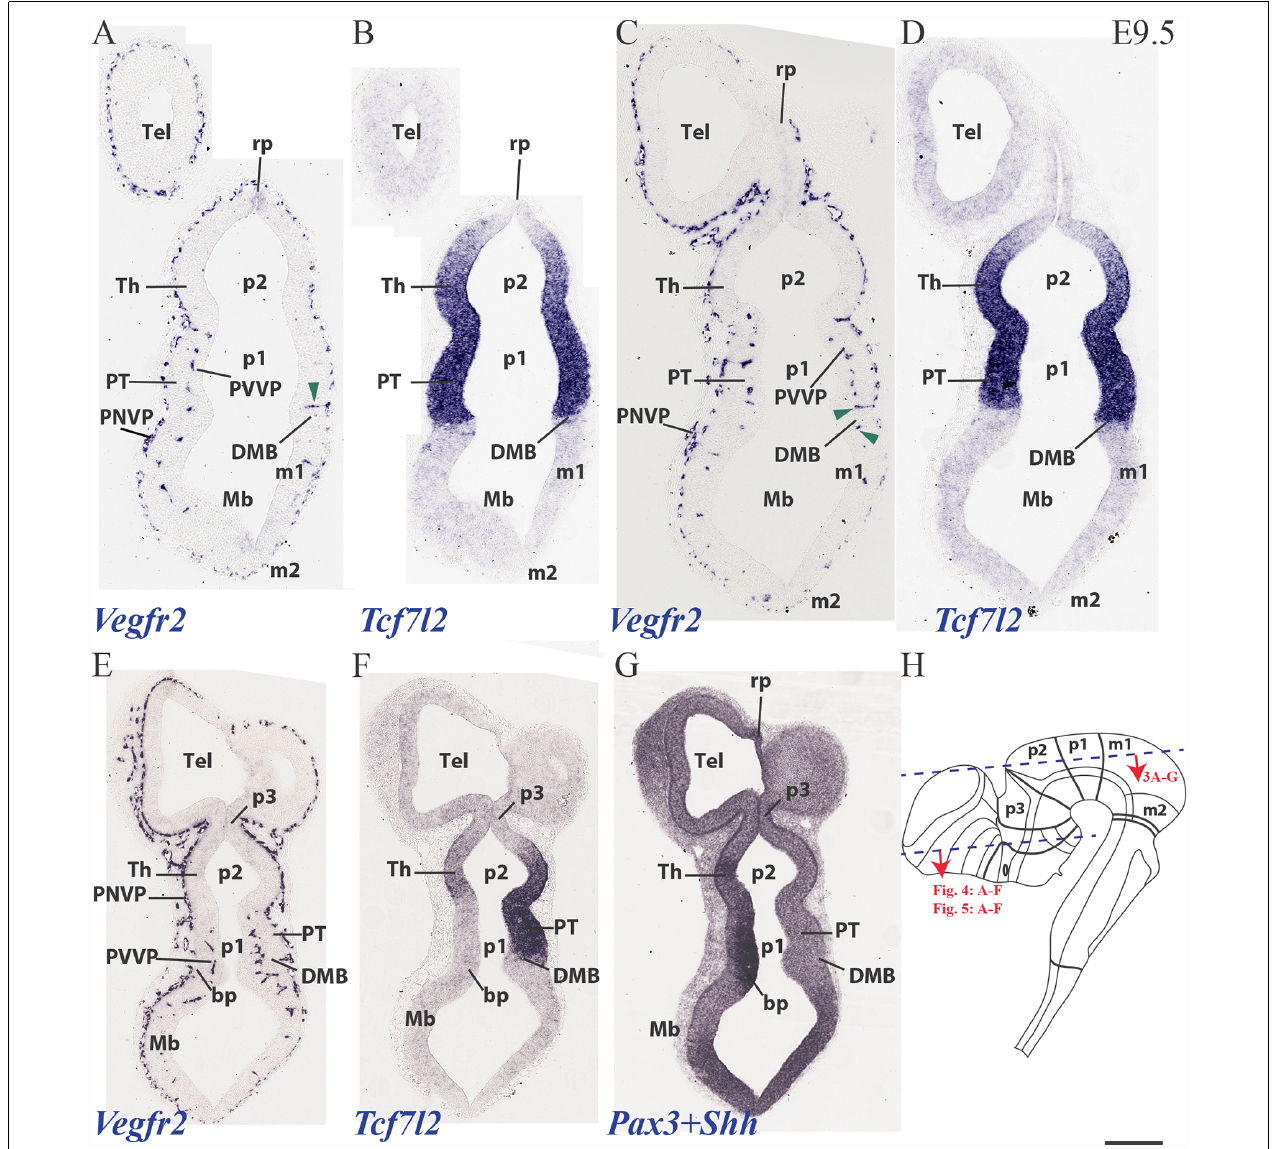
FIGURE 3 | Horizontal sections through a mouse telencephalon, diencephalon and mesencephalon at E9.5 showing the vascularization by the PNVP and early perforant and periventricular (PVVP) vessels (Vegfr2; A,C,E ), compared in consecutive sections with markers of diencephalic alar plate (Tcf7l2 and Pax3; B,D,F,G ) and basal plate (Shh; G ). See description in the text. Green arrowheads: perforant vessels. (H) Semi-schematic representation of the plane of section corresponding to the horizontal sections shown in Figures 3–5 . Scale bar: 250 µ